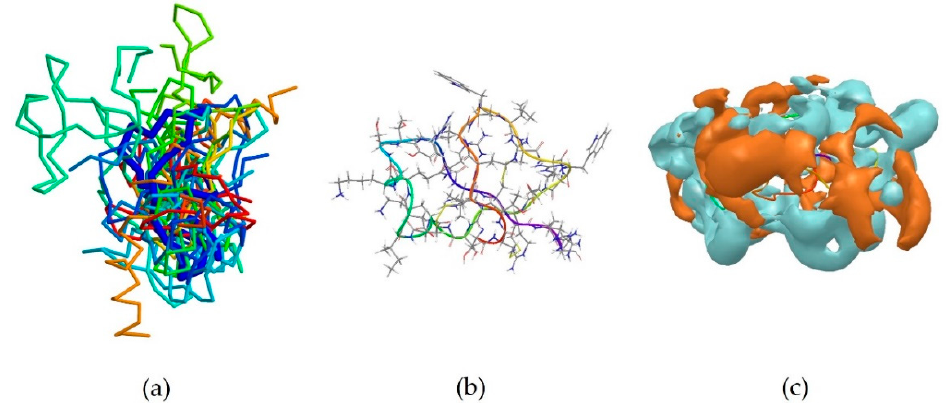
Figure 2. ( a ) Superimposition of all members of cluster 2 onto the backbone of the centroid 2MXQ (thick blue trace). The majority of the members of this cluster assume a partial β -sheet configuration, with only 2K35, 2MMM, 2MN5 and 2N8D including α -helix regions; ( b ) Stick and ribbon representations of the experimentally-derived conformation of 2MXQ which does not assume a definite conformation; ( c ) PDB structure 2MXQ, corresponding the defensin-like peptide DEFA1 is here shown. The hydrophilic region of the molecule surface is coloured in cyan, whilst the hydrophobic portion is shown in amber.